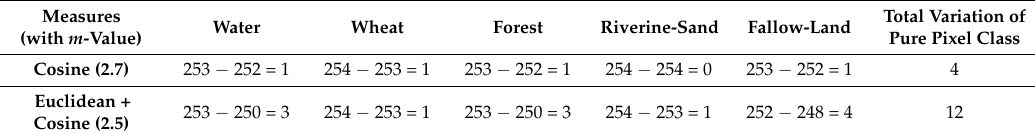
Table 5. The comparative results of the best single similarity measures and the composite measure while handling the pure pixel classes and also its behaviour within the class variation (membership value was calculated on 8-bit scale i.e., the target values for a class is 255 and 254 (with a variation of 1 within the class)).